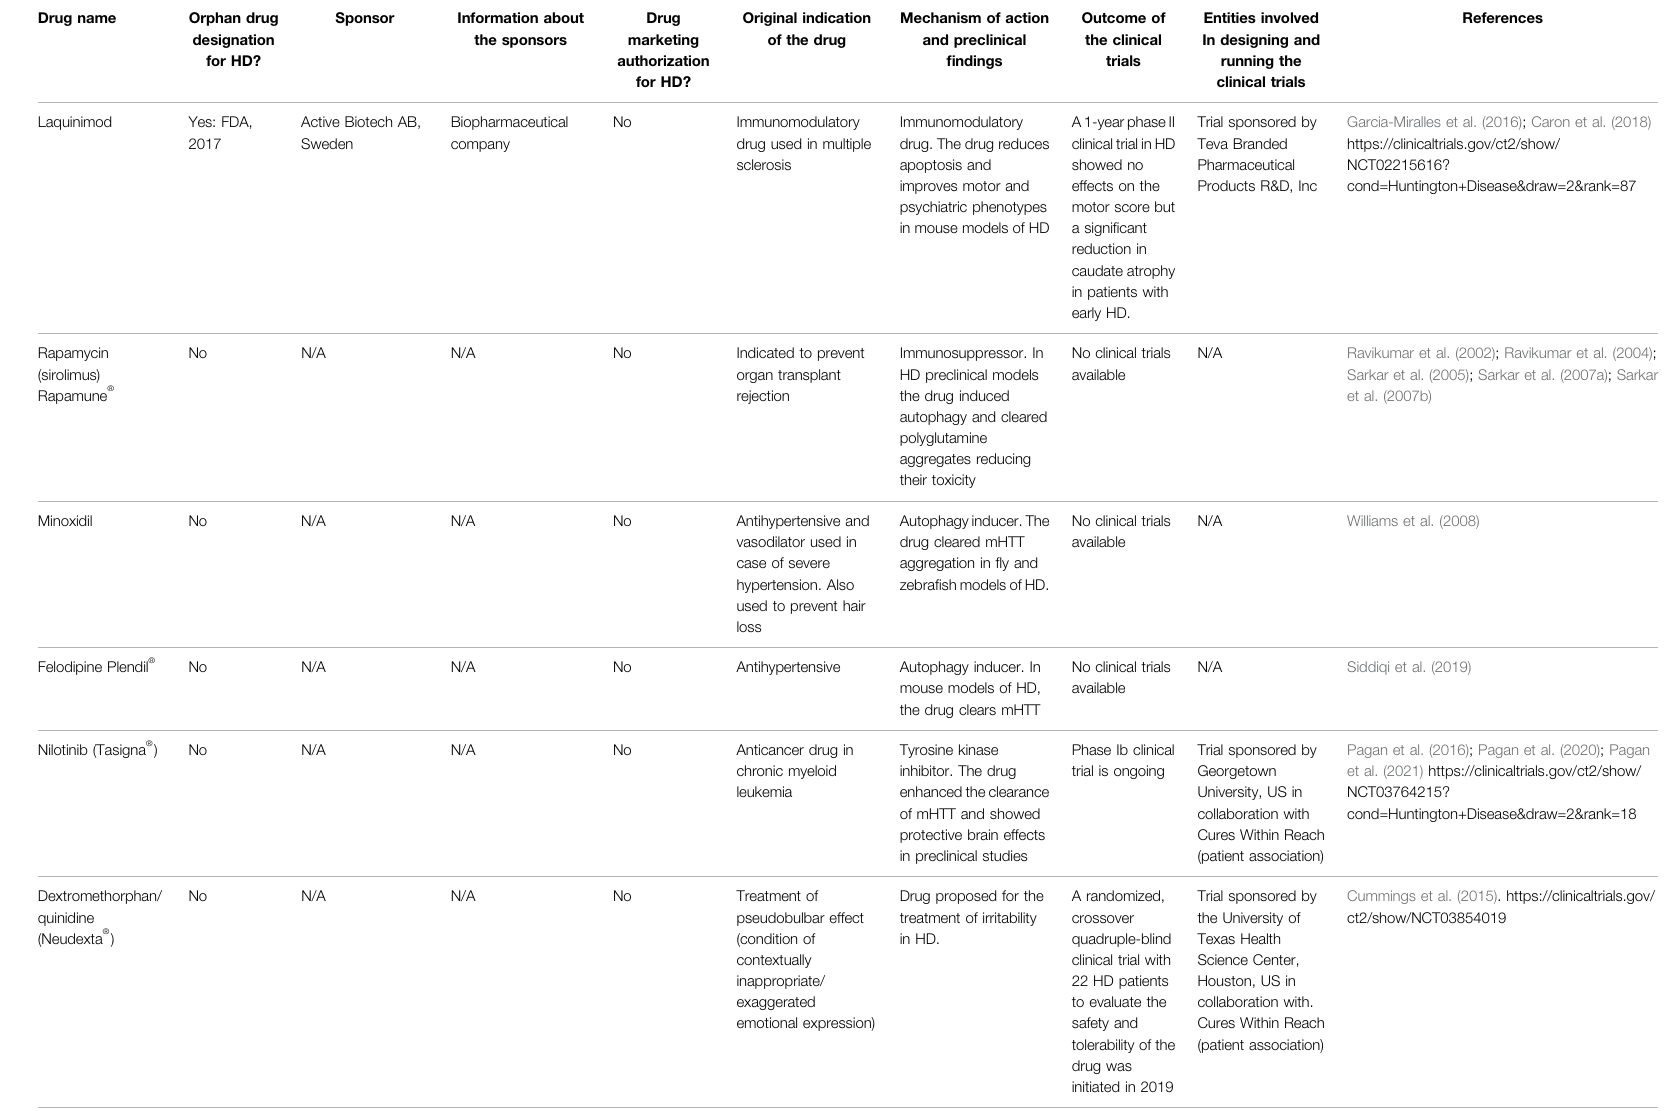
TABLE1| ( Continued )Listoftherepurposed drugs,withandwithoutorphandesignationordrugmarketingauthorization forHuntington ’ sdisease(HD)mentioned inthisarticle.Thesponsors(entitiesinvolvedinmakingthe orphan designation request to the EMA or the FDA), and the public or private organizations involved in designing and running the clinical trials are detailed. N/A (cid:1)